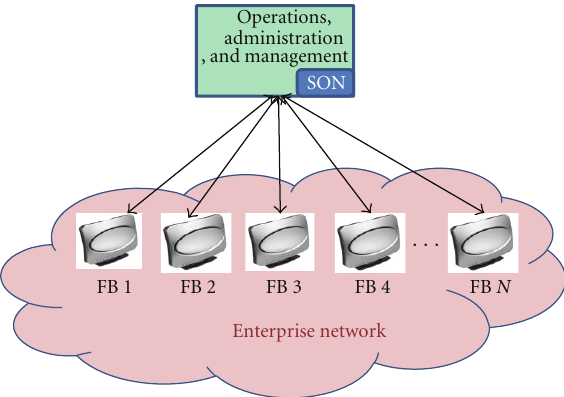
Figure 3: Centralized self-optimizing enterprise femtocell